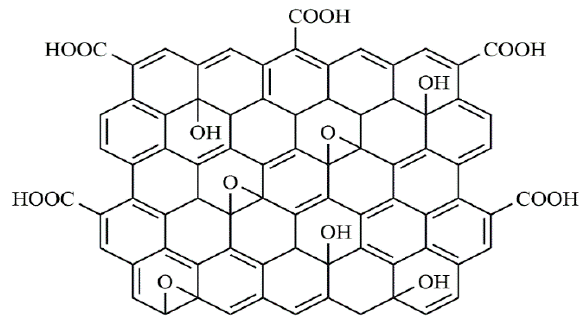
Figure 1. The possible structure of graphene oxide.